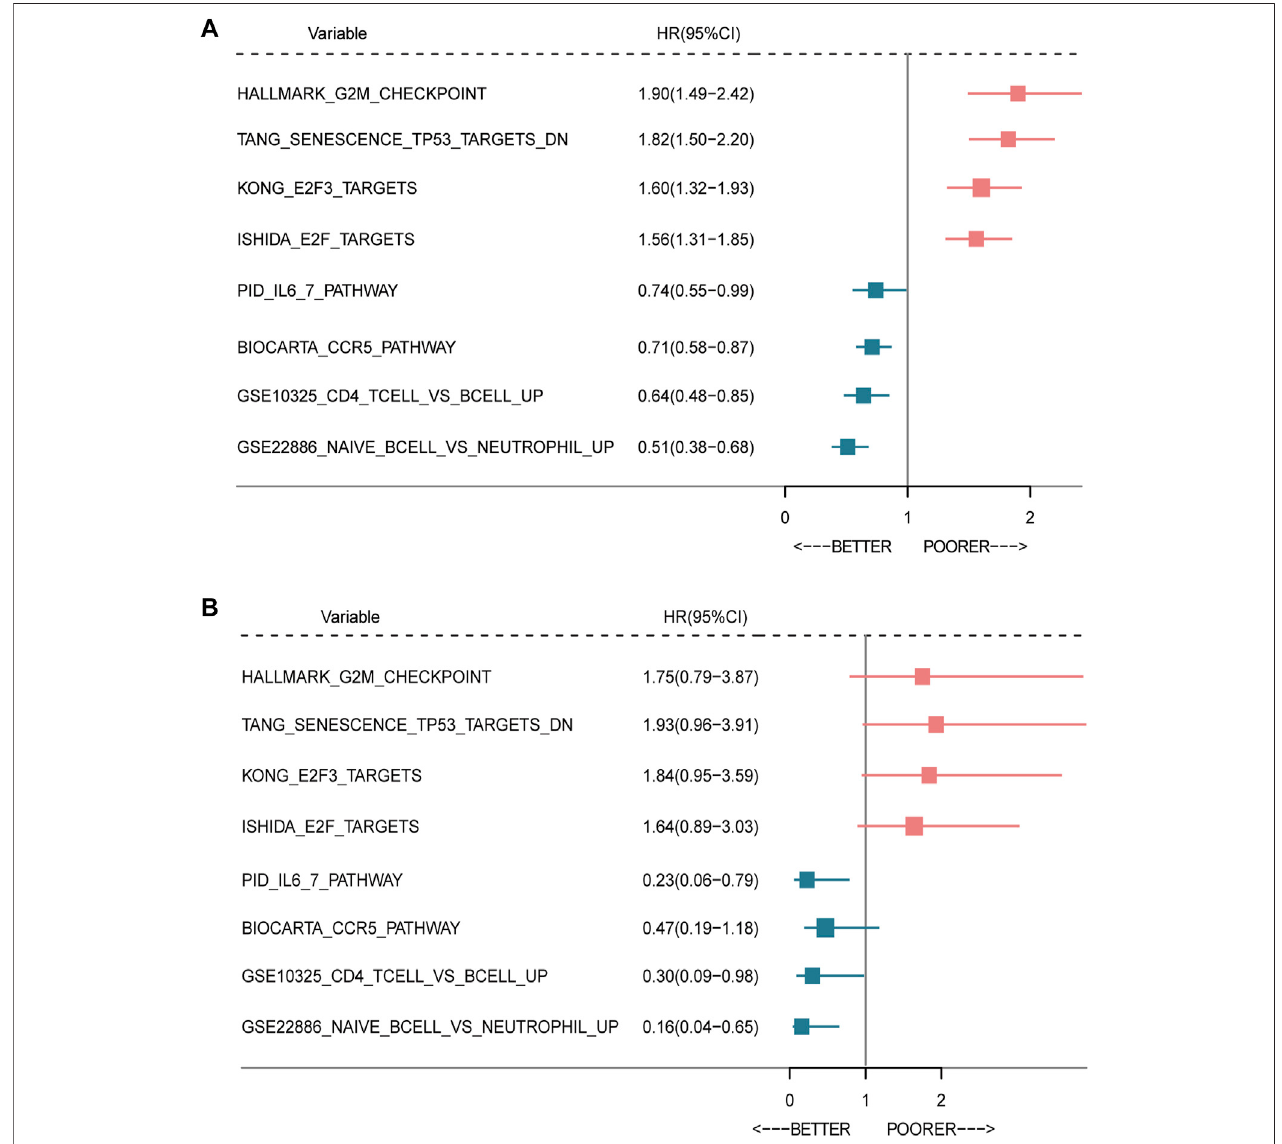
FIGURE 6 | Forest plot of prognostic signi fi cance of the seven-immune-related-gene IRS. Prognostic factors in the METABRIC cohort (A) and TCGA cohort (B) . IRS: immune risk signature; BC: breast cancer; TCGA: The Cancer Genome Atlas.